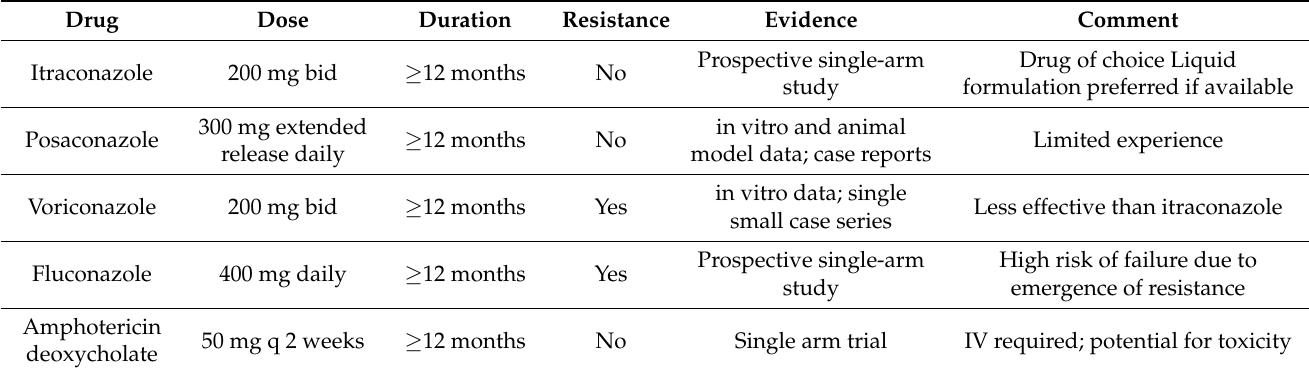
Table 2. Maintenance therapy for histoplasmosis in adults with HIV